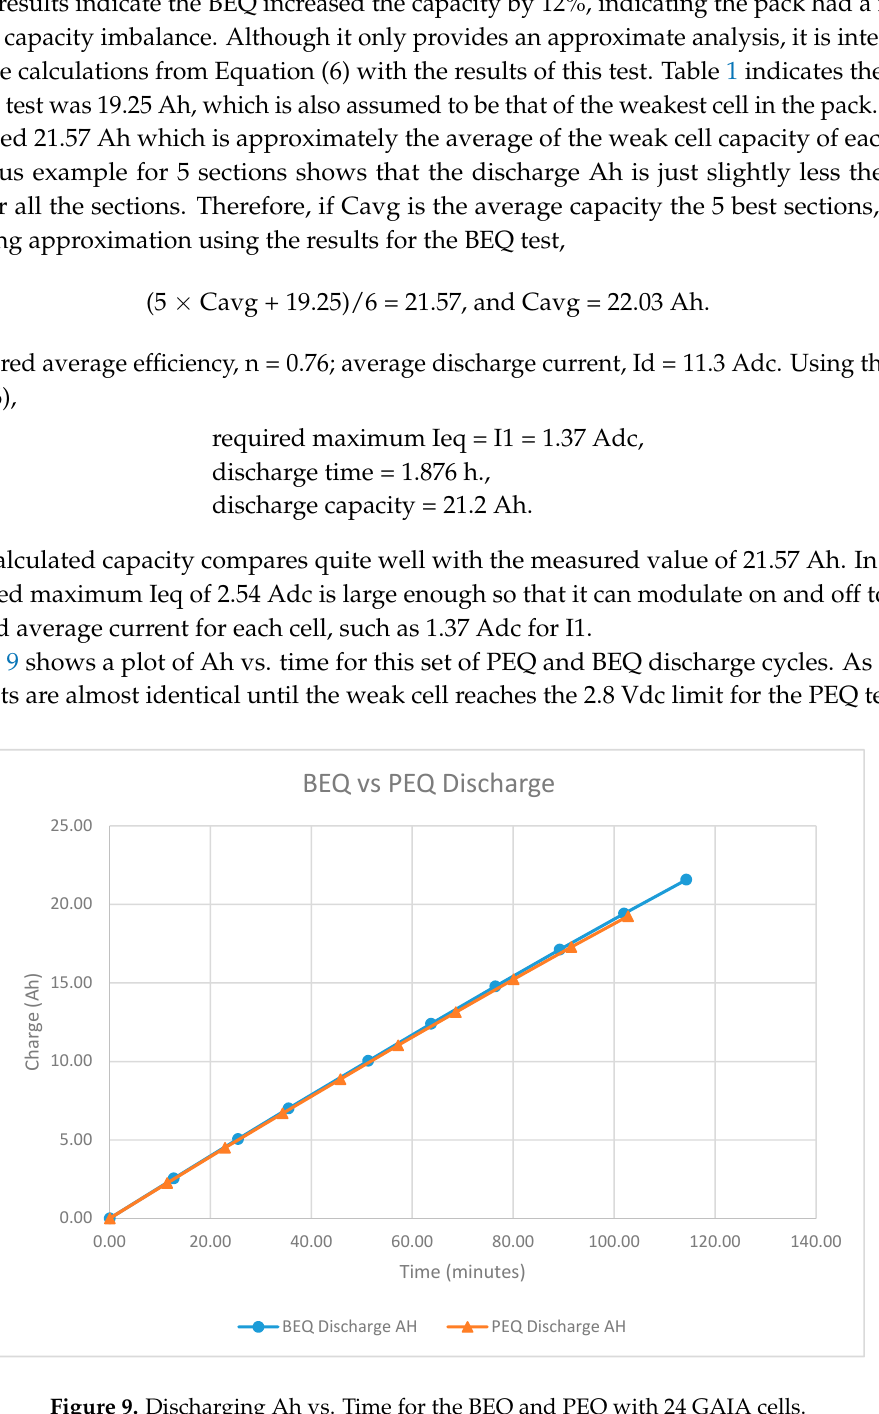
Table 1. Discharge data with 24 GAIA cells.